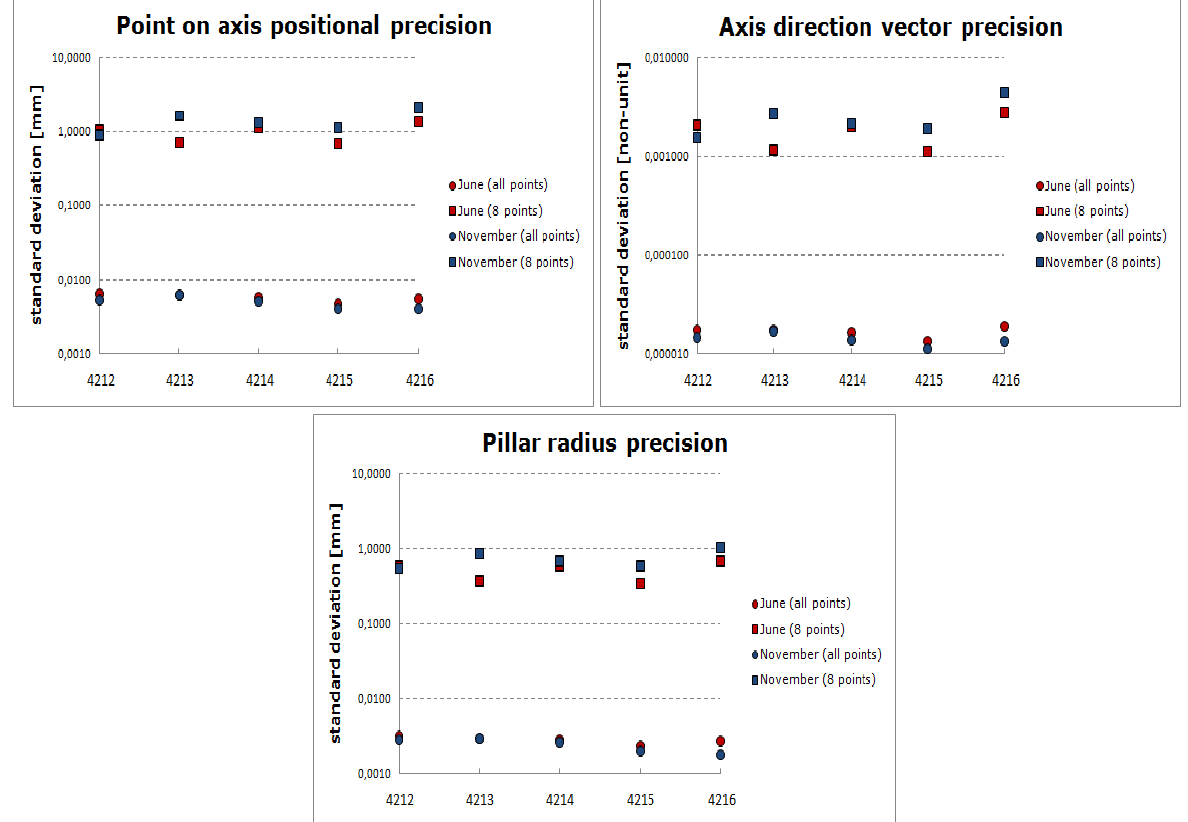
Figure 8. (a) The positional precision of points on the axes. (b) The axes direction vector precision. (c) Pillar radius precision. All shown in logarithmic